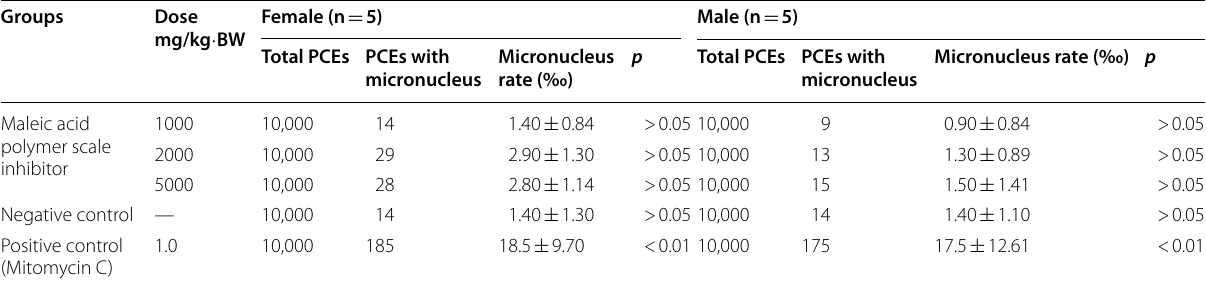
Table 2 Micronucleus test results of mouse bone marrow polychromatic erythrocytes